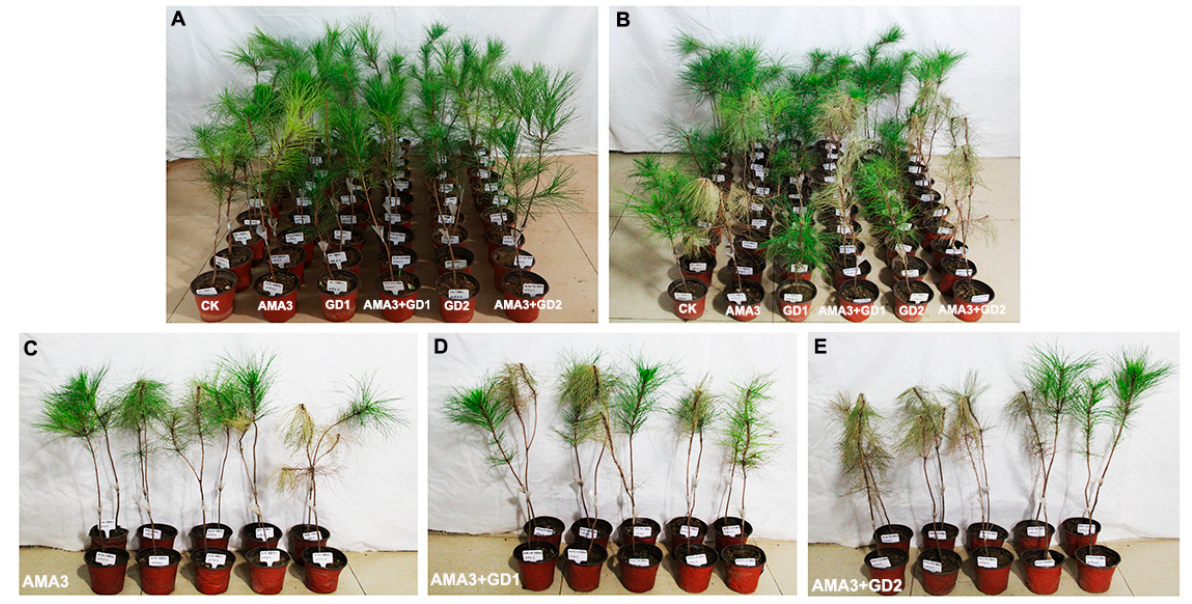
Figure 3. Symptoms of potted seedlings of Pinus massoniana ( P. massoniana ) after inoculation with Bursaphelenchus xylophilus ( B. xylophilus ), B. xylophilus treated with the bacterium from the body of the nematode (GD1), and B. xylophilus treated with the endophytic bacterium of P. massoniana (GD2). Each treatment of this experiment had ten saplings. ( A ) The symptoms of P. massoniana after inoculation for one day with AMA3, AMA3 treated with GD1, and AMA3 treated with GD2. ( B ) The symptoms of P. massoniana after inoculation for 40 days with AMA3, AMA3 treated with GD1, and AMA3 treated with GD2. ( C – E ) The symptoms of P. massoniana after inoculation for 40 days with AMA3 ( C ), AMA3 treated with GD1 ( D ), AMA3 treated with GD2 ( E ). Control group (CK) was only inoculated with 2 mL of sterile deionized water. Table 3. Disease incidence and disease index (DI) of Pinus massoniana inoculated with di ff erent treat- The needles faded and yellowed first, and then withered and turned reddish ments of pine wood nematodes. CK—control group.